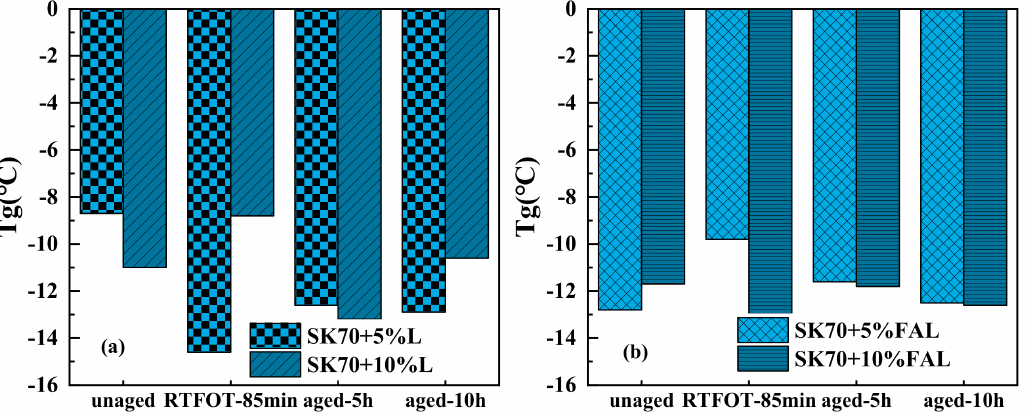
Figure 12. Glass-transition temperature Tg value/ ◦ C. ( a ) Lignin modified asphalt: ( b ) Formic acid lignin modified asphalt.